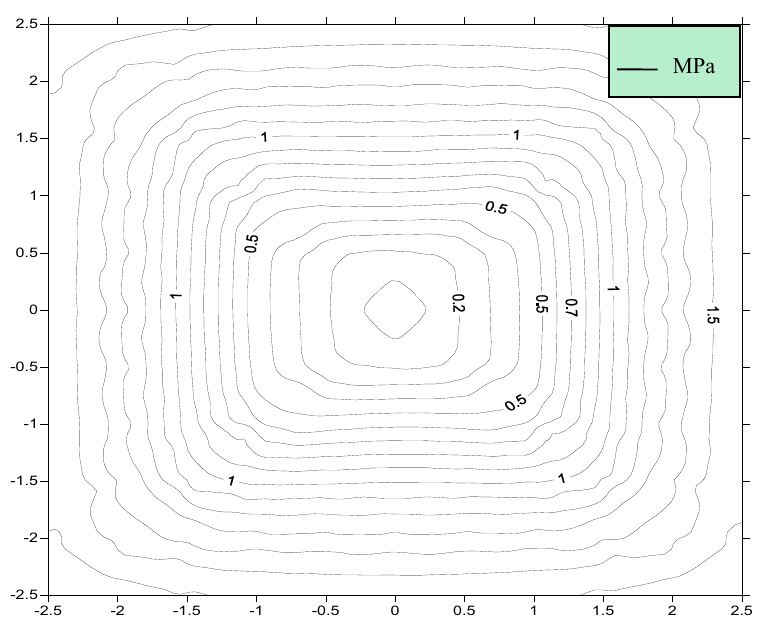
Figure 7 . When T = 400 K, the distribution of gas pressure around boreholes. Figure 7. When T = 400 K, the distribution of gas pressure around boreholes.